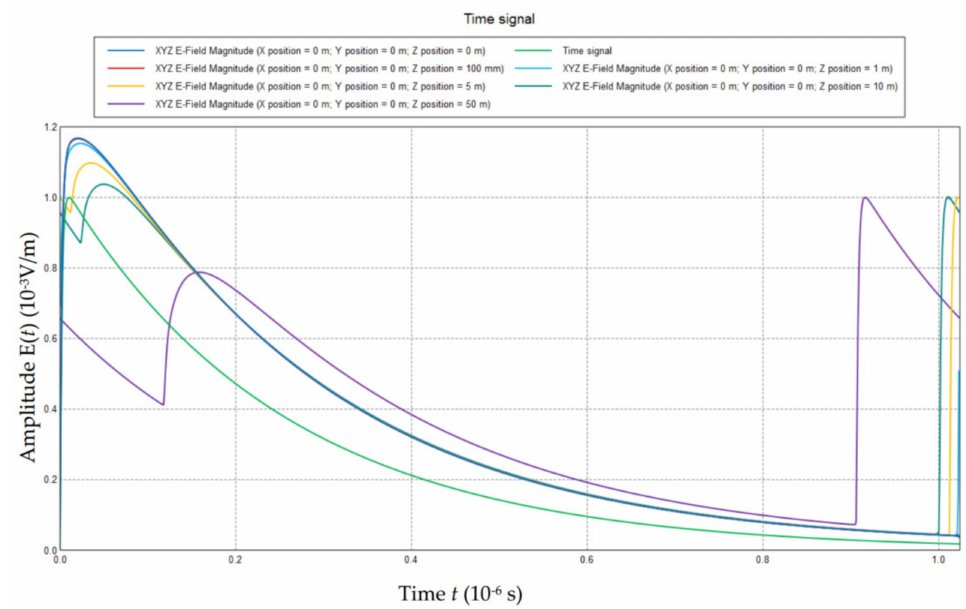
Figure 6. Electric field strength distribution E ( t ) at various values of z with α = 0 ◦ outside aircraft with E = 1